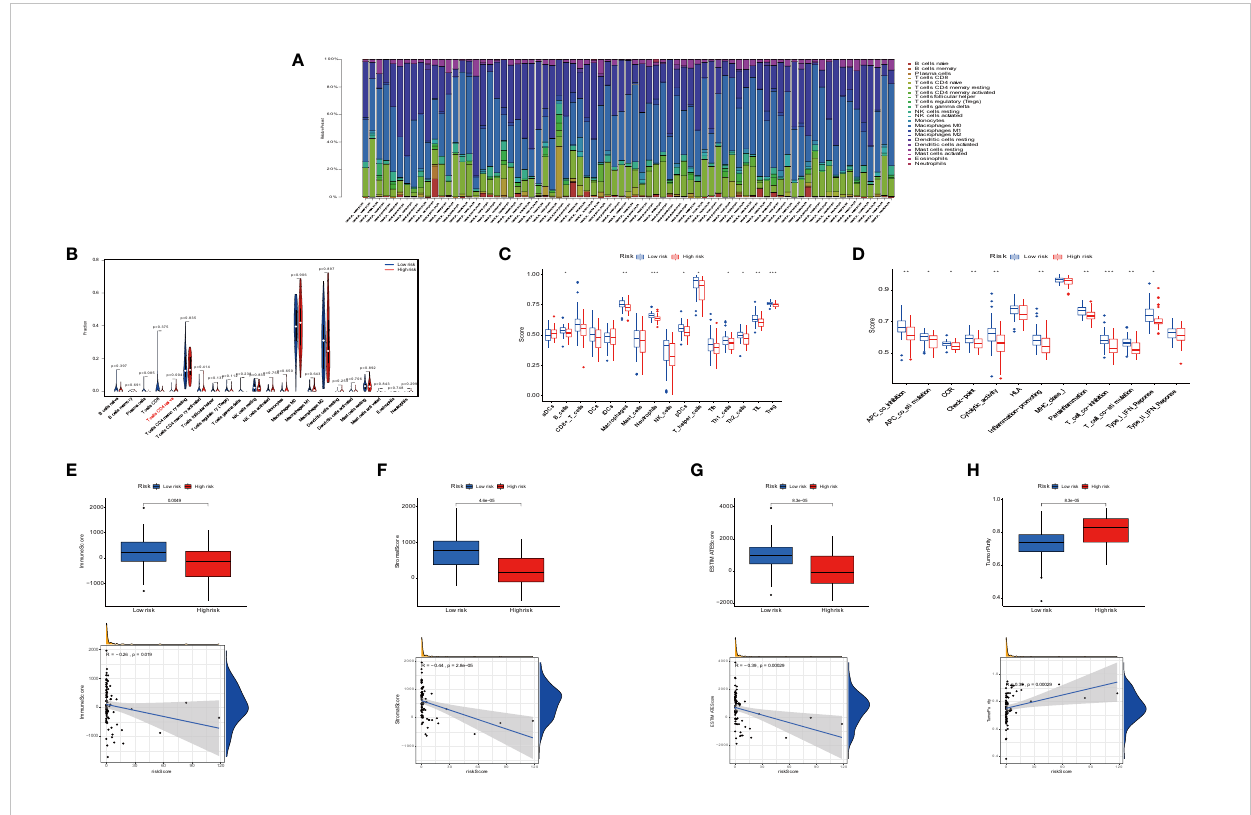
FIGURE 8 Immune signature in the low- and high-risk groups. (A) Proportion of 22 immune cell types in osteosarcoma risk groups. (B) Expression of immune cells between two groups. (C) The differential expression of cell in fi ltration between risk groups is based on the ssGSEA scores. (D) Immune functional difference between risk groups. (E – H) Differential expression of tumor microenvironment scores (immune scores, stromal scores, ESTIMATE scores, and tumor purity) between risk groups. * P < 0.05, ** P < 0.01, *** P <